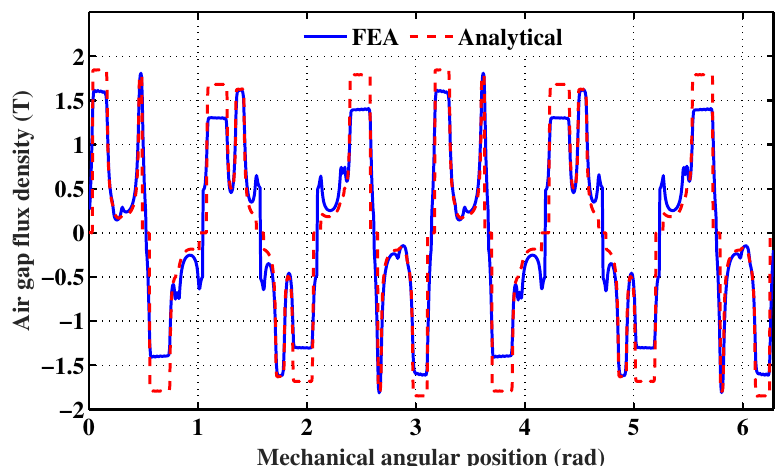
Figure 7. PM flux density spatial repartitions with the stator and rotor slotting effects and the rotor position correction taken into account: (analytic) without saturation correction, (FEA) B–H curve implemented.